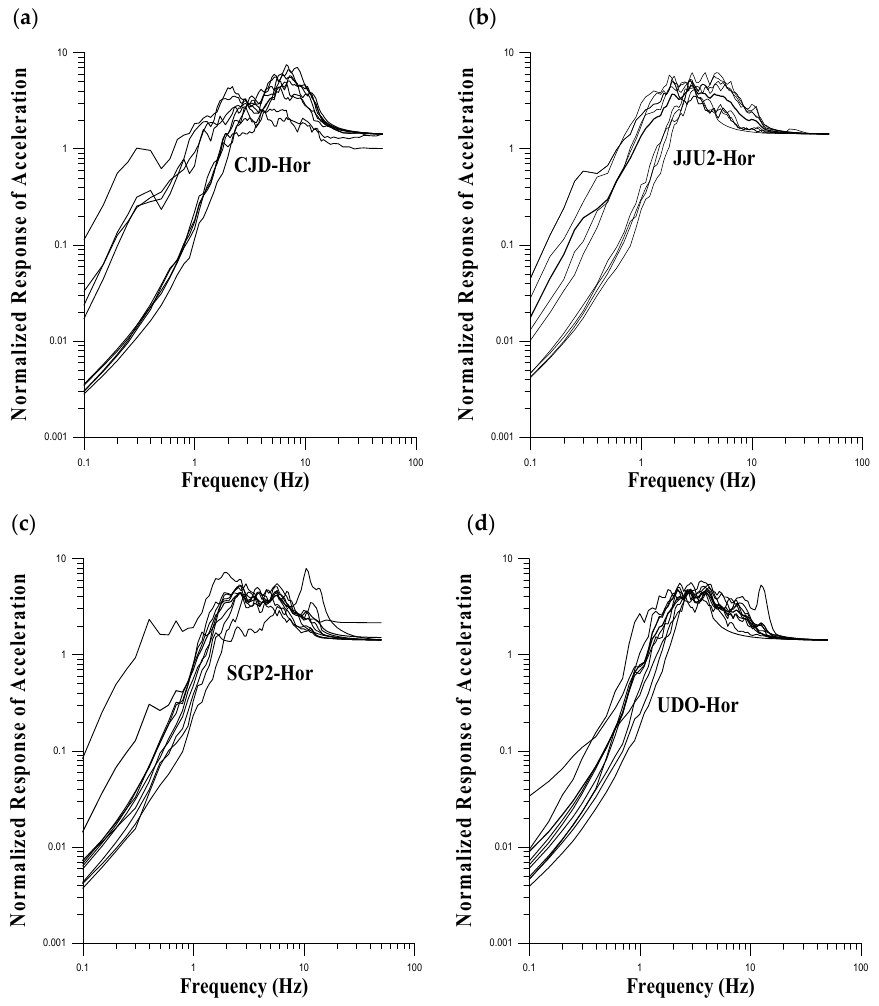
Figure 5. Normalized horizontal response spectra at ( a ) CJD, ( b ) JJU2, ( c ) SGP2, and ( d ) UDO using Pohang earthquakes series.